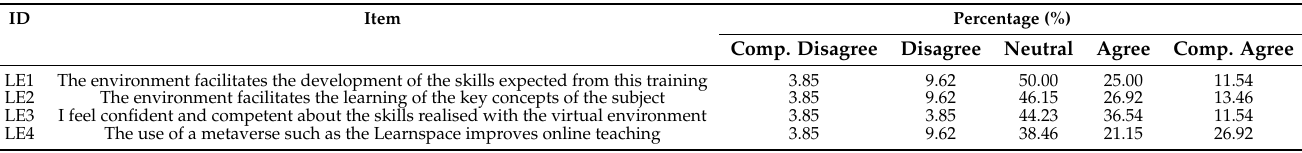
Figure 13. Survey results for ‘Learning Experience’. Table 7. Numerical results for ‘Learning Experience’.